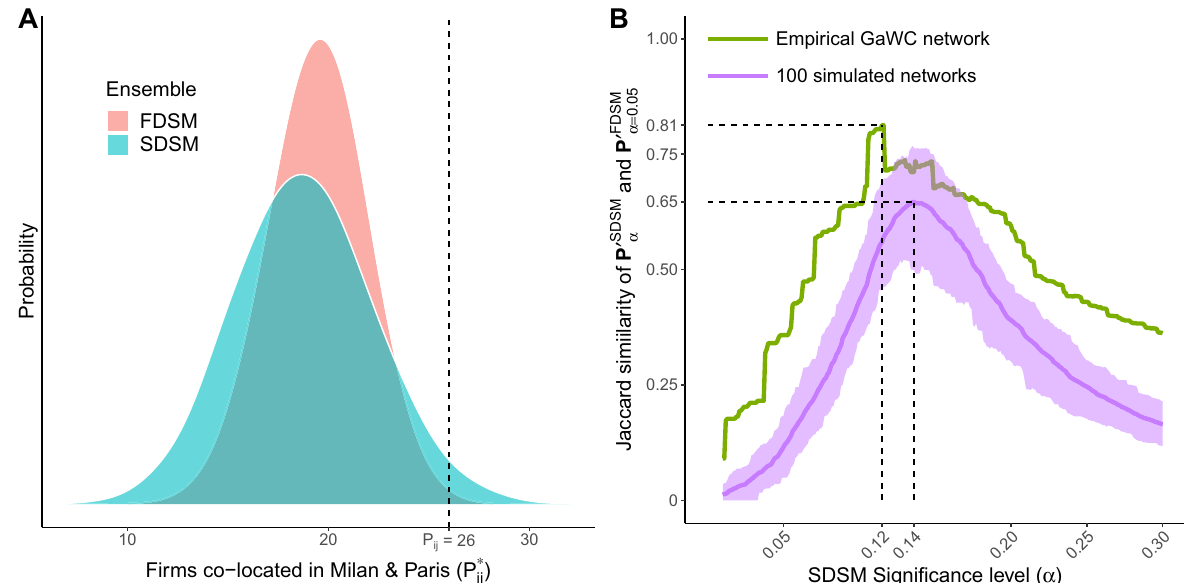
Figure 2. Statistical power of SDSM. ( A ) Distribution of weights for the Paris-Milan edge in projections derived from FDSM and SDSM ensembles. ( B ) Similarity of an FDSM backbone extracted at α = 0.05 to SDSM backbones extracted at various α from an empirical bipartite network (green line) and from 100 synthetic bipartite networks (purple line = mean, purple region = 10th – 90th